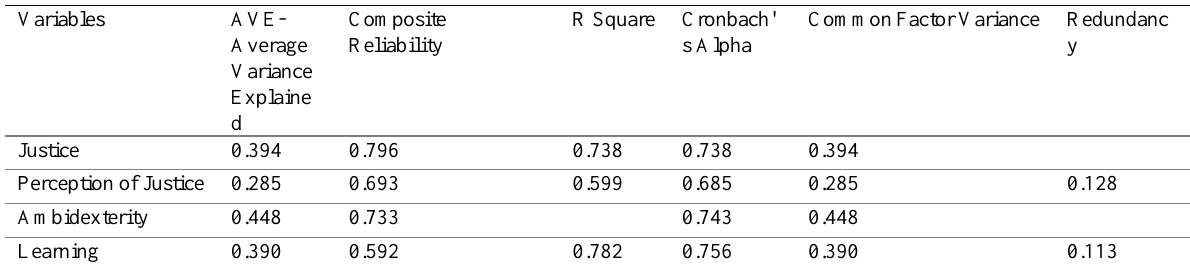
Table 1: Validity and Reliability Analysis Table